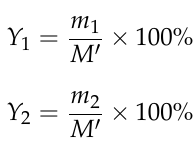
Figure 14. Test bench of Seeding performance experiments. To test the seeding performance of this device, 250 consecutive garlic seeds were ran- domly selected for each group of tests to measure statistics and repeated three times. The test results were averaged and recorded. Since the pass rate + missed seeding rate + reseeding rate = 100%, two of them are known to obtain the third one, so the pass rate Y 1 and missed the seeding rate Y 2 were selected as evaluation indicators to measure the seeding performance. The evaluation index formula [33] is as